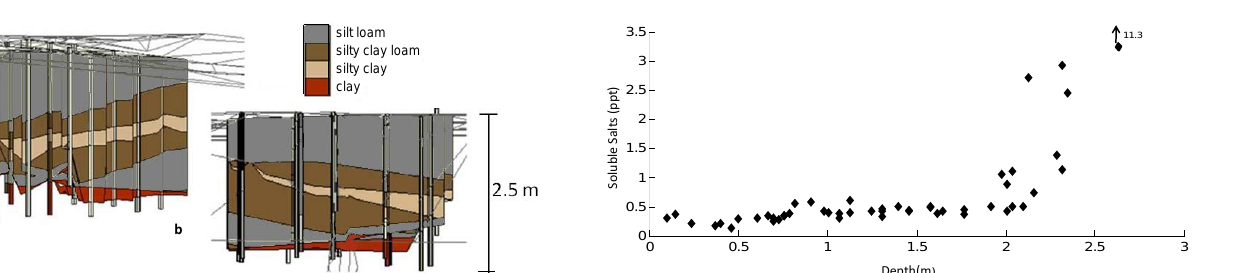
Fig. 3. Soluble salts for soil samples collected during well excava-